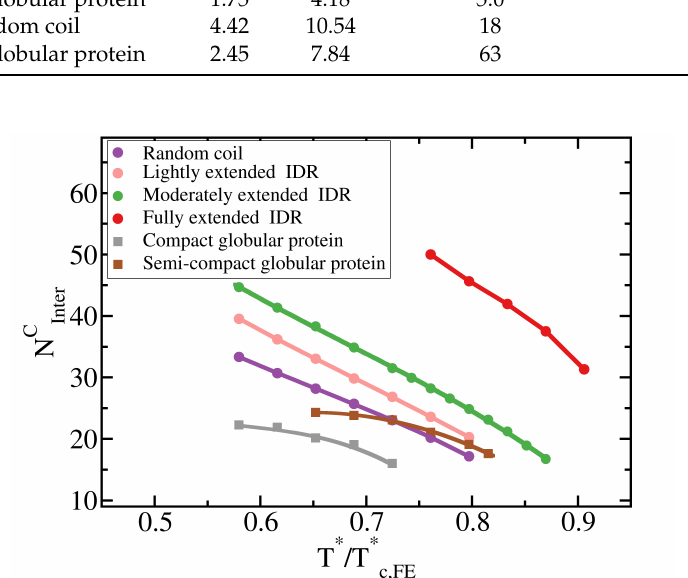
Figure 4. Liquid-network connectivity explains LLPS. Average number of inter-molecular contacts per protein in the condensed liquid phase, N C proteins described in the